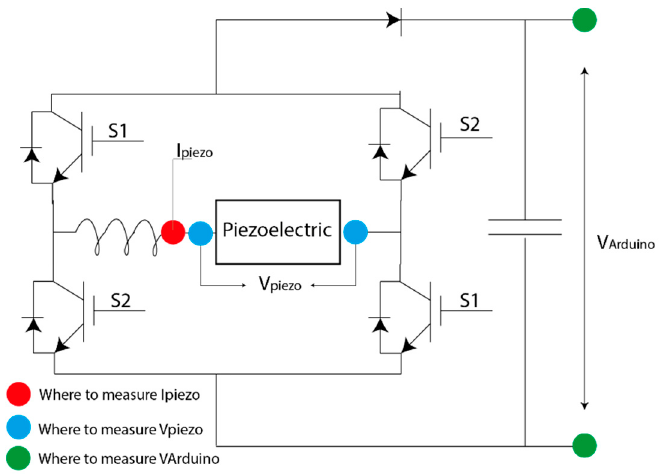
Figure 4. Electronic circuit that works at the maximum power point.